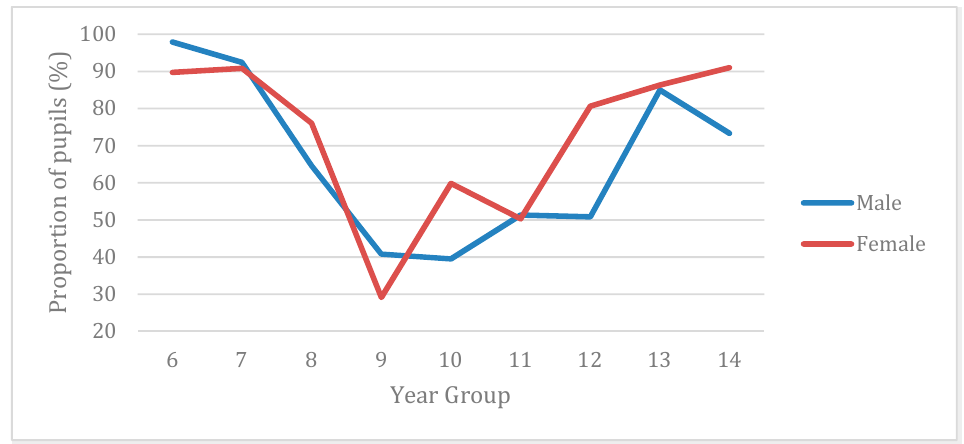
Figure 2. Proportion of males and females not achieving the recommended amount of physical education per year group.